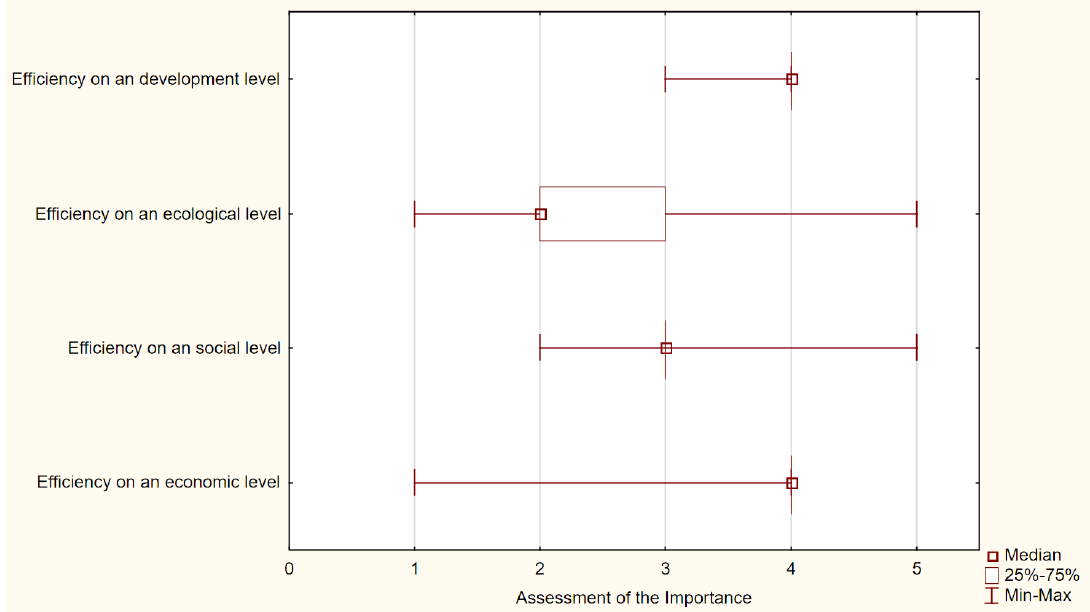
Figure 5. A box-and-whisker chart subjective evaluation of effectiveness at different levels according to the respondents.